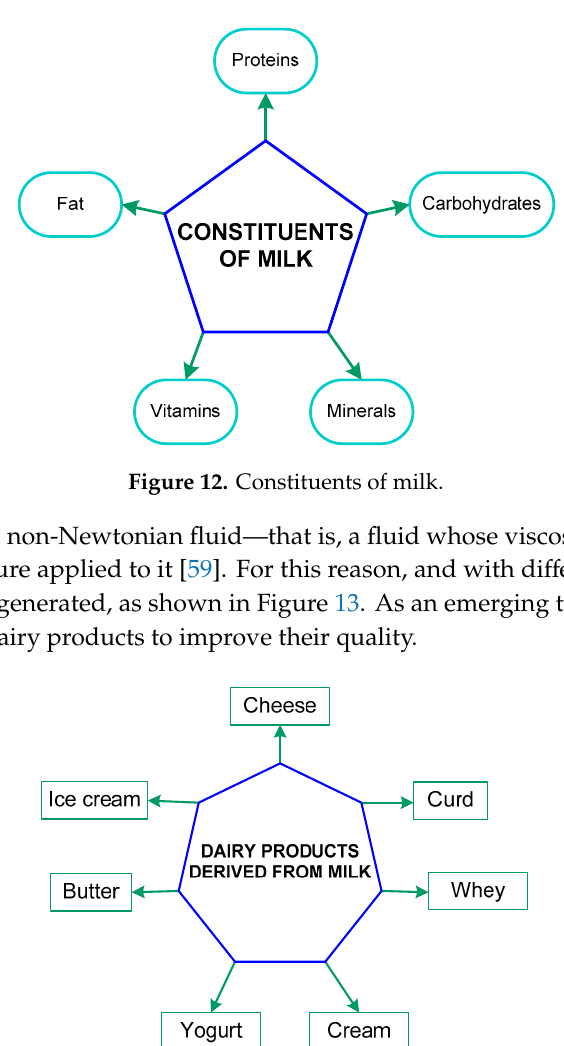
Figure 13. Dairy products derived from milk.